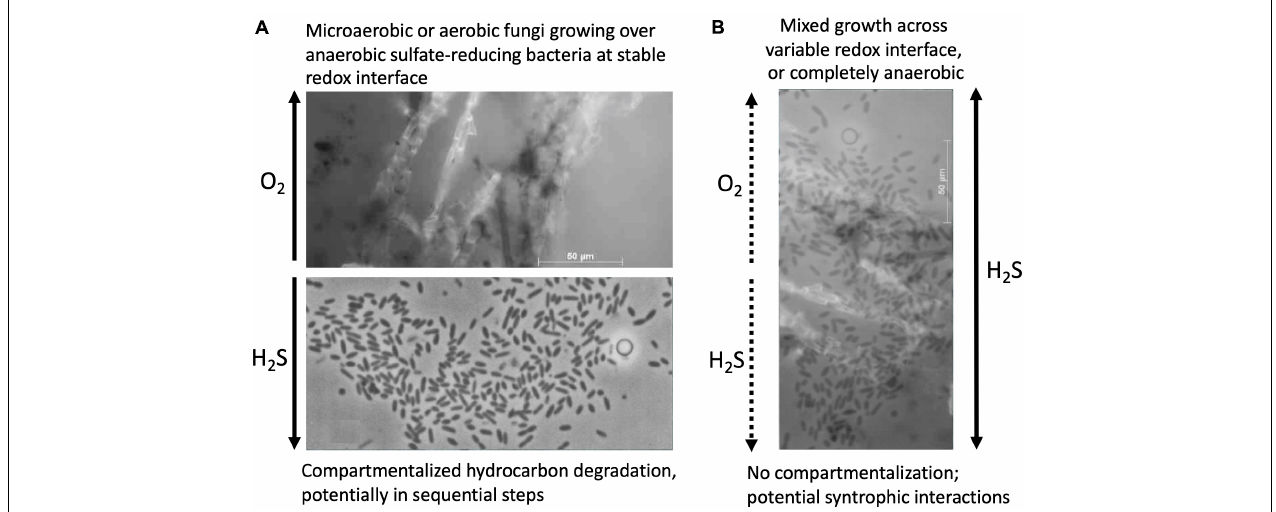
FIGURE 5 | Concept sketch for potential interactions of hydrocarbon-degrading fungi and sulfate-reducing bacteria in Guaymas Basin sediments. (A) Spatially separated, redox-stratified niches for aerobic hydrocarbon-degrading fungi and sulfate-reducing anaerobic bacteria, implying compartmentalized hydrocarbon degradation in distinct steps. (B) Co-occurrence and potential syntrophic associations of hydrocarbon-degrading fungi and sulfate-reducing bacteria in sediments with fluctuating redox gradients, or fully sulfidic conditions, visualized by superimposition of both microphotographs. The fungal isolate used for this sketch is Cladosporium _GB1 ( Table 1 ) grown on naphthalene as sole carbon source; the bacterial image shows Desulfothermus naphthae strain TD3, a thermophilic hexadecane-degrading sulfate reducer from Guaymas Basin sediments (Rüter et al., 1994).